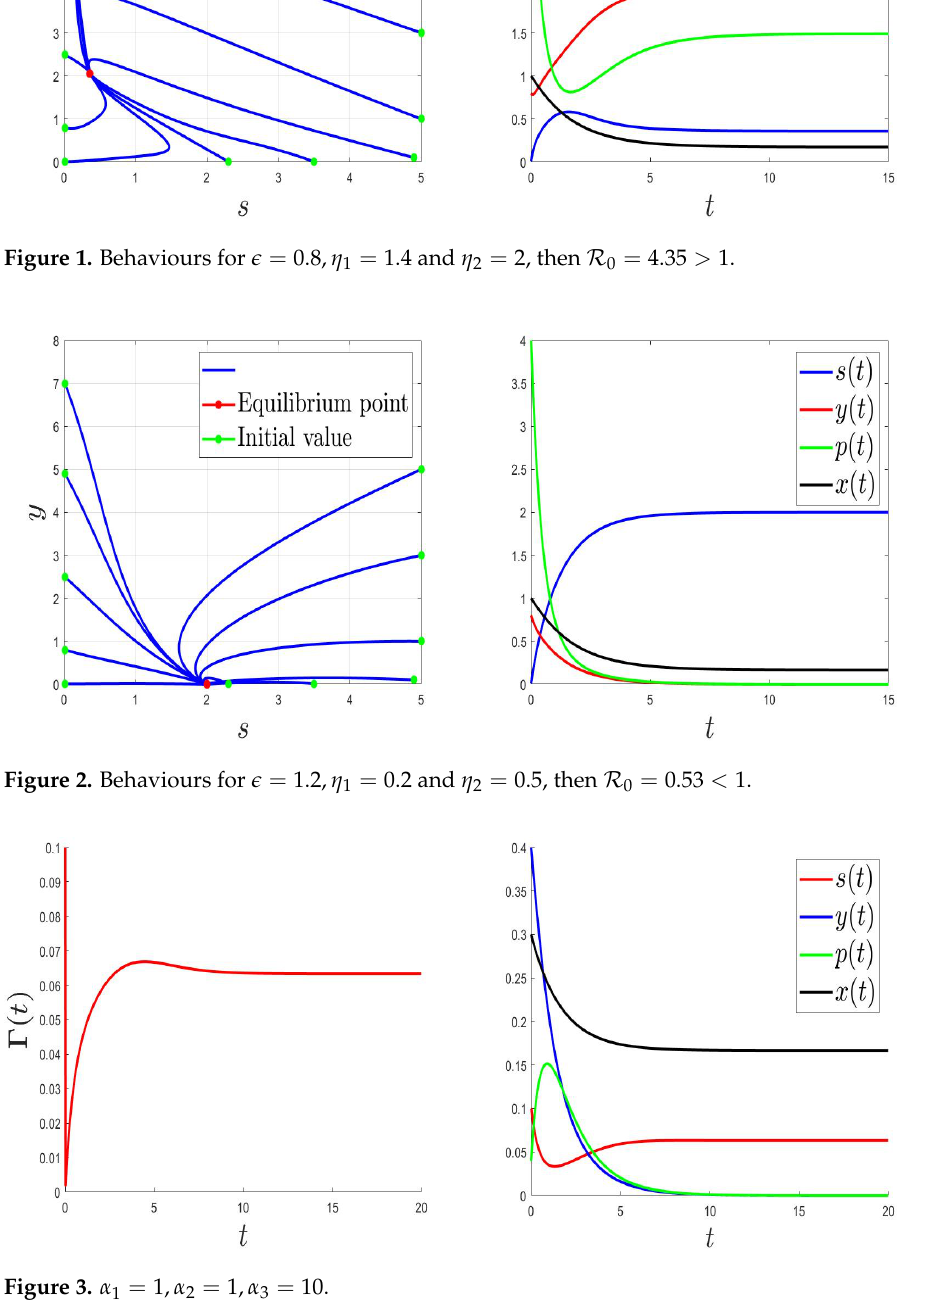
Figure 3. α 1 = 1, α 2 = 1, α 3 =